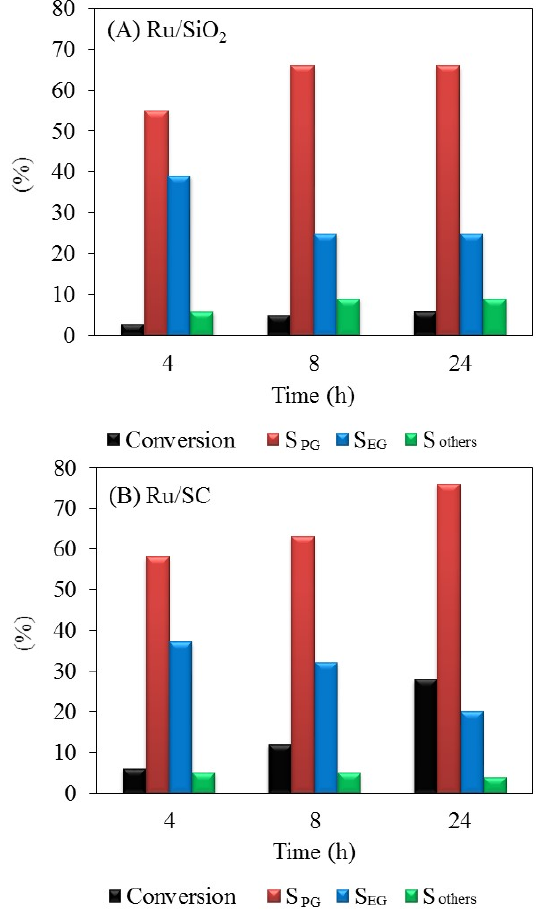
Figure 5. Conversion and selectivities to 1,2-propylene glycol ( S PG ), ethylene glycol ( S EG ), and methanol + ethanol + 1-propanol + acetol ( S others ) in glycerol hydrogenolysis for the catalysts studied. ( A ) Ru/SiO 2 ; ( B ) Ru/SC. Reaction conditions: 50 g of catalyst per liter of solution. Glycerol aqueous solution (10 wt %), 200 °C, 20 bar H 2 .